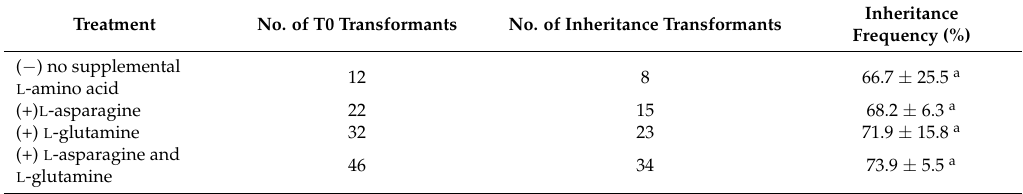
Table 7. Inheritance frequency of T0 transformants for the different treatments.